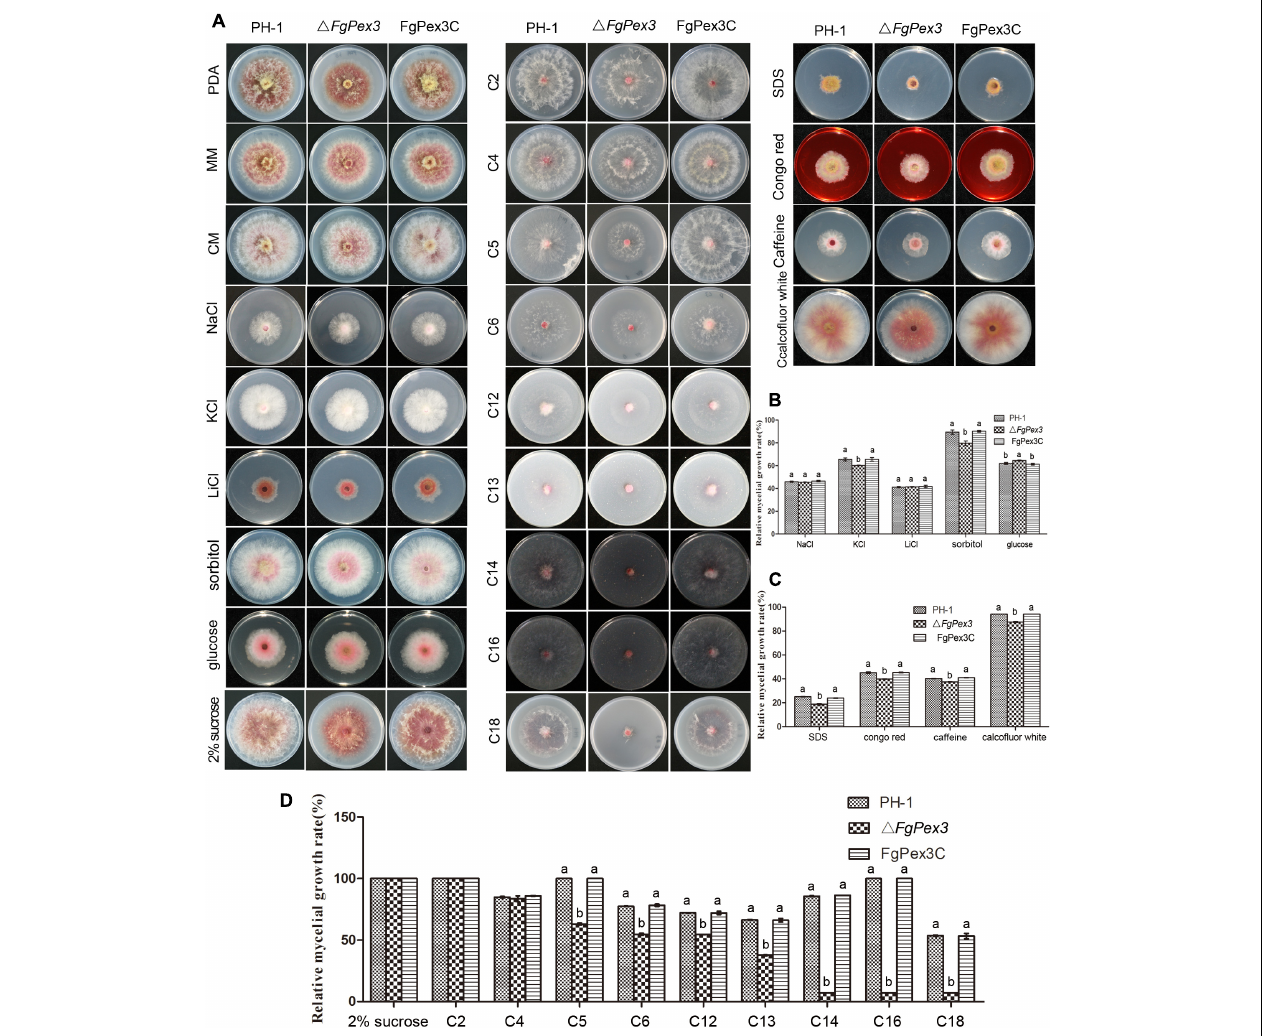
FIGURE 4 | Growth analysis of F. graminearum strains under different culture conditions. (A) The wild-type PH-1, deletion mutant and the complemented strain were cultured on three basic media (PDA, CM, and MM) as well as MM plates supplemented with osmotic stress agents (NaCl, KCl, LiCl, sorbitol or glucose), MM plates amended with either cell wall damaging agents (SDS, Congo red, caffeine or calcofluor white) or with various carbon sources (2% sucrose, 40 mM sodium acetate (C2), 40 mM sodium butyrate (C4), 40 mM sodium valerate (C5), 40 mM sodium hexanoate (C6), 3 mM laurate acid (C12), 3 mM tridecanoic acid (C13), 3 mM myristic acid (C14), 3 mM palmitic acid (C16) or 3 mM oleic acid (C18) as the sole carbon source) at 25 ◦ C for 3 days. (B–D) Colony diameters of the tested strains were measured to calculate the inhibition rate and statistically analyzed. Error bars represent the deviation from five replicates, and the same letter on the bars for each treatment indicates no significant difference at P =